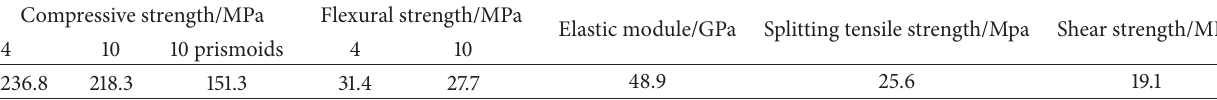
Table 2: Mechanical properties of RPC200.